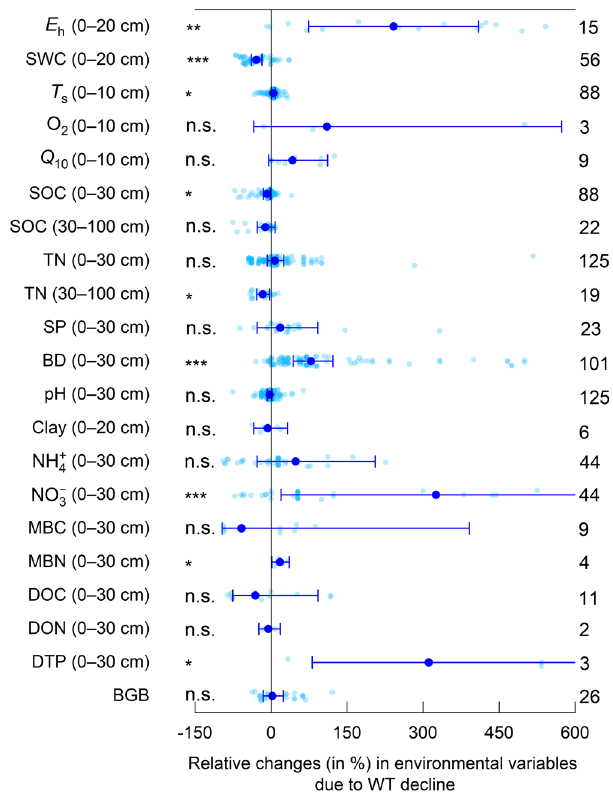
Fig. 3 Relative changes in environmental variables due to water table (WT) decline in pristine peatlands. E h (soil redox potential), SWC (soil water content), T s (soil temperature), O 2 (oxygen), Q 10 (temperature sensitivity coef fi cient), SOC (soil organic carbon concentration), TN (total nitrogen concentration), SP (soil phosphorus concentration), BD (soil bulk density), pH, clay content, NH þ (soil ammonium concentration), soil NO (cid:1) 3 4 (soil nitrate concentration), MBC (microbial biomass carbon), MBN (microbial biomass nitrogen), DOC (dissolved organic carbon), DON (dissolved organic nitrogen), DTP (dissolved organic phosphorus) and BGB (belowground root biomass). The larger solid circles and horizontal bars denote the weighted means of relative changes and their 95% con fi dence intervals. The smaller circles and numbers indicate individual relative changes due to WT decline and the number of data points, respectively. The asterisks *, **, *** indicate signi fi cance at the levels of p < 0.05, 0.01 and 0.001, respectively, and n.s. indicates no signi fi cance (for details, see Meta-analysis in Methods). E h was denoted as the net change (treatment – control, in mV) due to WT decline (for details, see Meta-analysis in 7%, n = 125; 30 – 100 cm: – 17%, n = 19), SP (18%, n = 23), soil (48%, n = 44), MBC ( – 58%, n = 9) and DOC ( – 31%, NH þ 4 n = 11) (Fig. 3). In addition, WT decline did not signi fi cantly affect the coef fi cient of temperature sensitivity ( Q 10 , 42%, n = 9), soil pH ( – 3%, n = 125) or BGB (2%, n = 26) (Fig. 3).